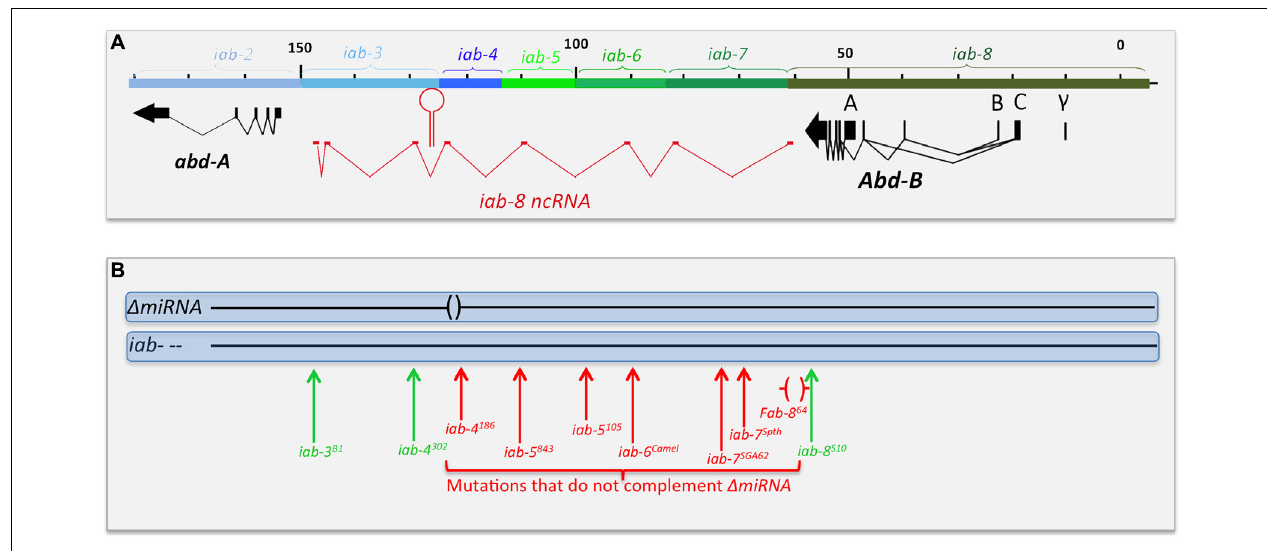
FIGURE 6 | Chromosomal breaks to the right of the miR-iab-8 fail to complement (cid:2) miRNA . Panel A shows the genomic map of the abdominal region of the BX-C as described in Figure 2 . Panel B symbolizes the two homologs chromosomes of heterozygotes between Δ miRNA and various